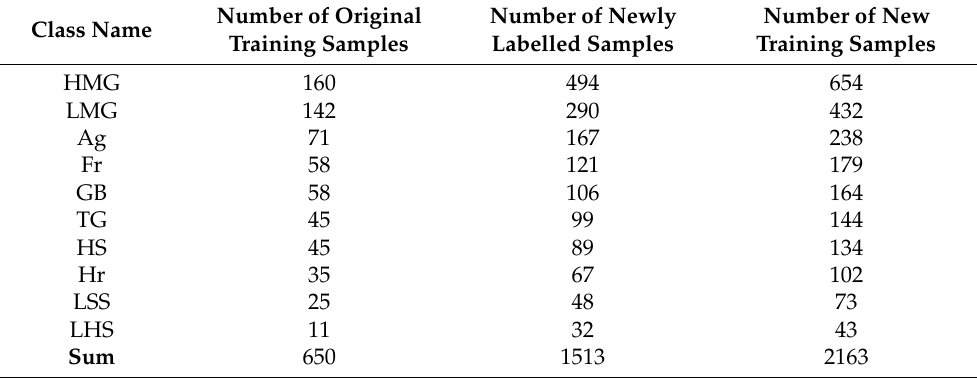
Table 5. The number of original training samples, newly labelled samples, and new training